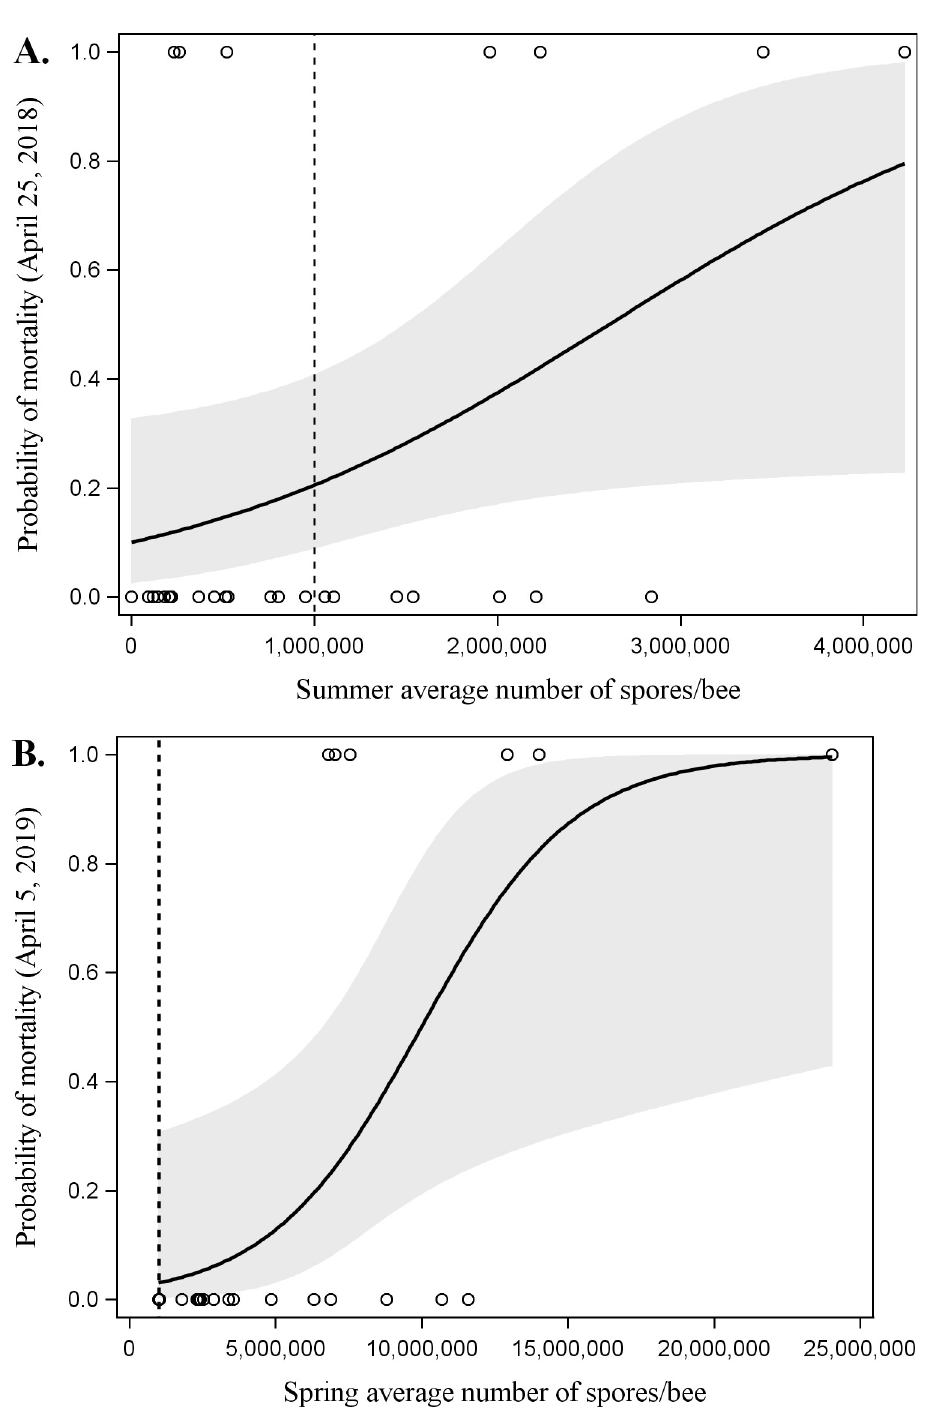
Fig 5. (A) The effect of average Nosema abundance in the previous summer (July-August, 2017) on the predicted probability of having dead colonies in spring 2018 (cumulative colony mortality on April 25, 2018). (B) The effect of average Nosema abundance in the previous spring (April—June, 2018) on the predicted probability of having dead colonies in spring 2019 (cumulative colony mortality on April 5, 2019). Shaded area is the 95% confidence limit. Dashed line shows the 1 million spores/bee nominal threshold. The circles indicate whether colonies were alive (0) or dead (1) at a specific Nosema abundance.